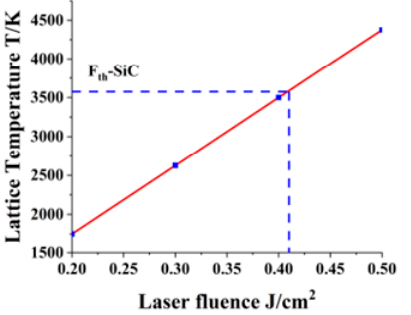
Figure 5. Relationship between lattice’s maximum temperature and laser fluence